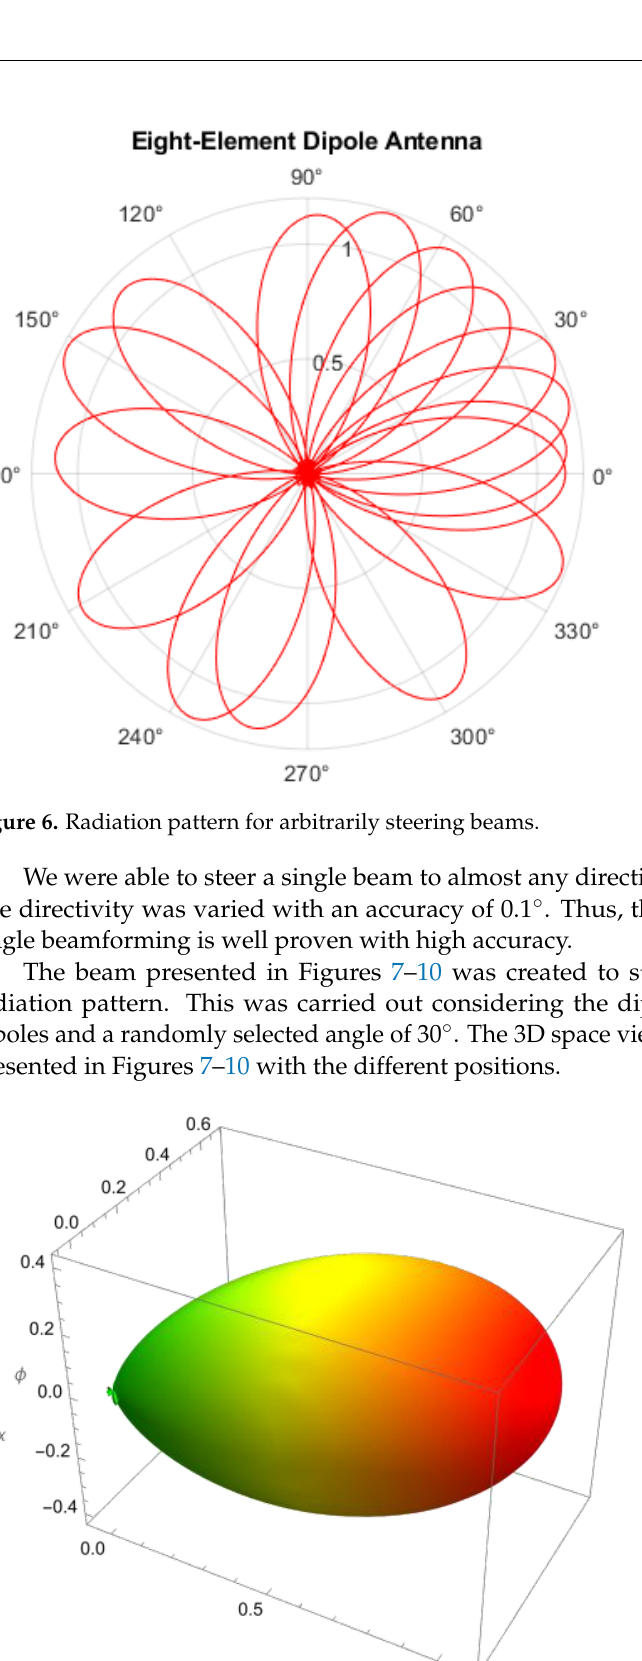
Figure 5. Proposed eight-element dipole antenna.